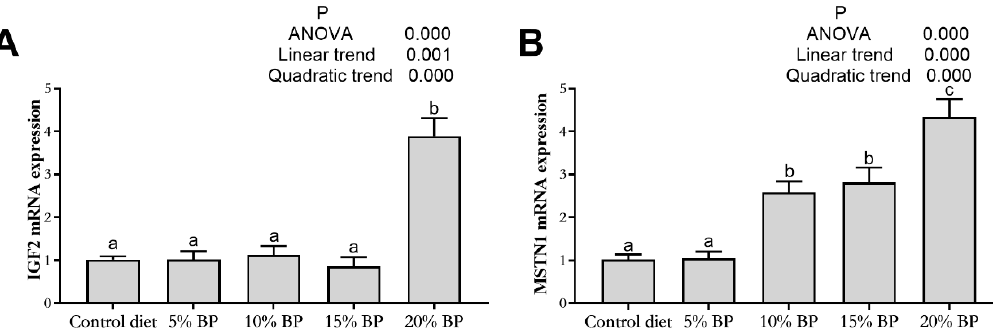
Figure 4. The gene expression of muscle growth regulatory factors in the muscle of grass carp fed a diet with paper mulberry (BP) for 8 weeks. IGF2 = insulin-like growth factor 2 ( A ), MSTN1 = myostatin 1 ( B ). Different letters (a,b)indicate significant differences ( p < 0.05, n = 3).